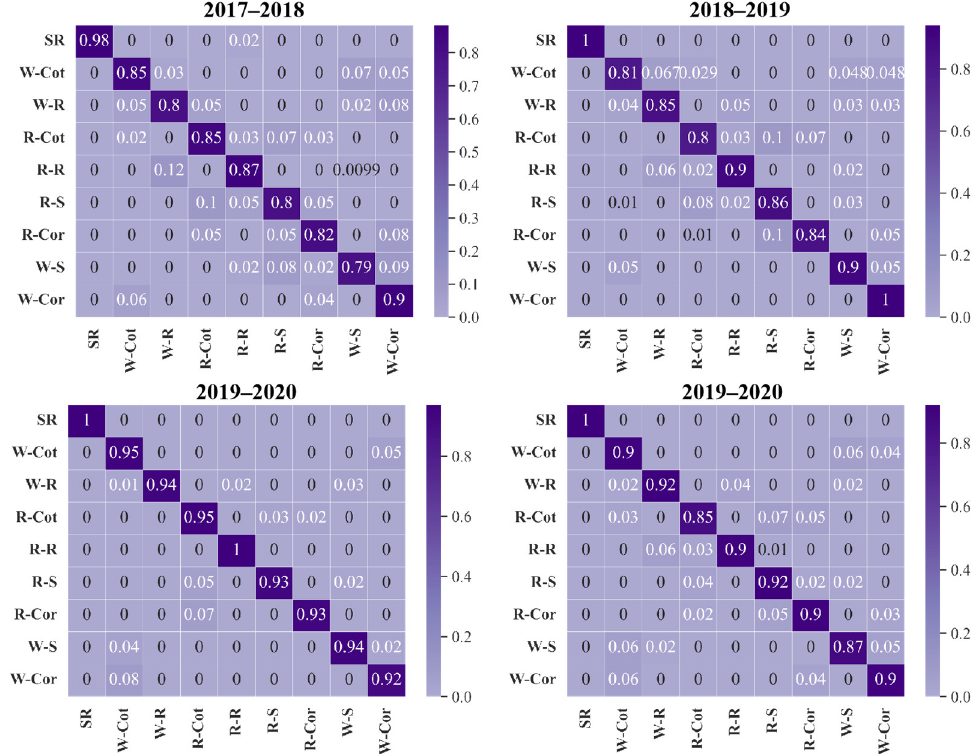
Figure 7. Confusion matrix thermal diagrams (SR: single rice; W–Cot: wheat–cotton; W–R: wheat–